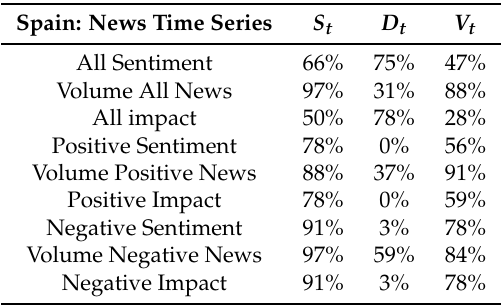
Table 1. Percentage of significant correlations between spread and sentiment time series for long-term bonds issued by